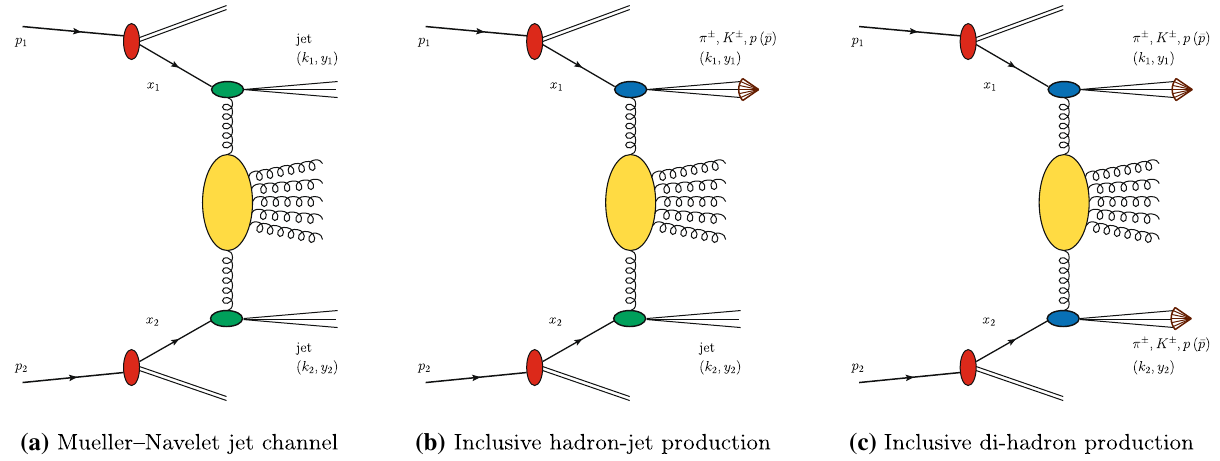
Fig. 2 Diagrammatic representation of the three semi-hard processes investigated. The BFKL gluon Green’s function is schematically repre- sented in yellow, while the hard factor of the jet (hadron) impact factor is portrayed by the green (blue) blob. Collinear PDFs describing the